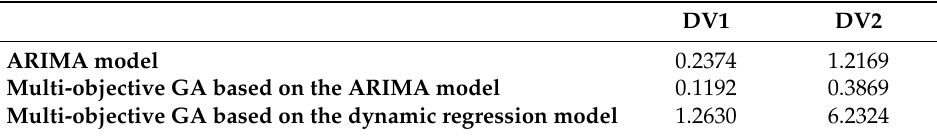
Table 1. The deviation averages for the labour cost object for every method.